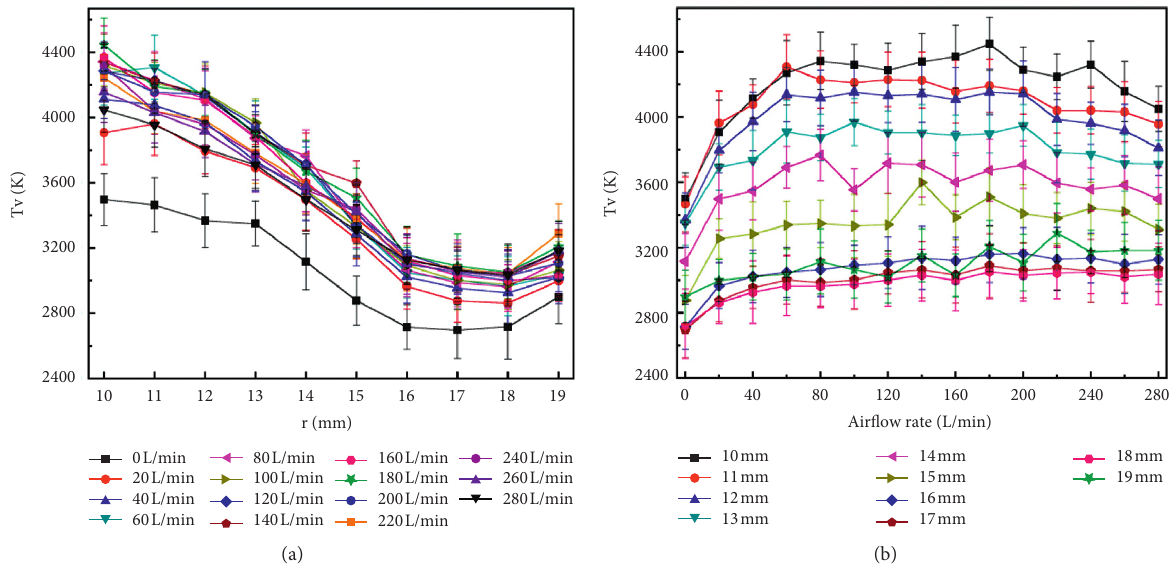
Figure 13: (a) Vibrational temperature varied with the radius of the coaxial DBD-PACA at different airflow rate; (b) vibrational temperature varied with the airflow rate at different